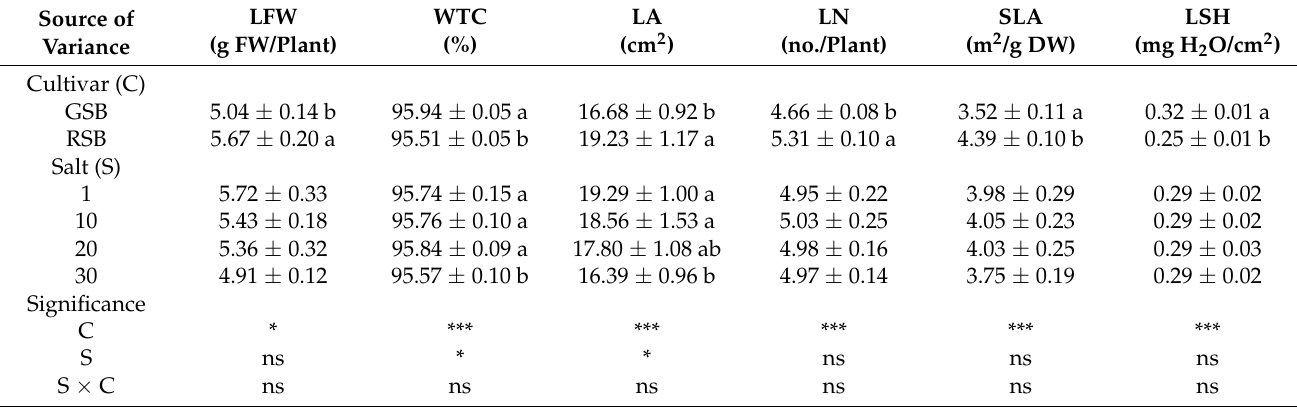
Table 1. Main effect of the cultivar (C), salt concentration (S; in mM NaCl), and their interaction on the leaf morphological parameters. The significance of the factors and their interactions was evaluated with a two-way ANOVA (ns: not significant; *: p < 0.05; ***: p < 0.001), using Duncan’s multiple range test as post-hoc test for mean separation among conditions. In case of simple main effect of C or S, different letters indicate, for each variable, different homogenous groups according to Duncan’s test for S, or the Student’s t -test for C. GSB: ‘Green Salad Bowl’; RSB: ‘Red Salad Bowl’. Salt concentration is in mM NaCl. LFW: harvested leaves per plant (LFW); WTC: water content: LA: leaf area per plant; LN: leaf number per plant; SLA: specific leaf area; LSH: leaf succulence.